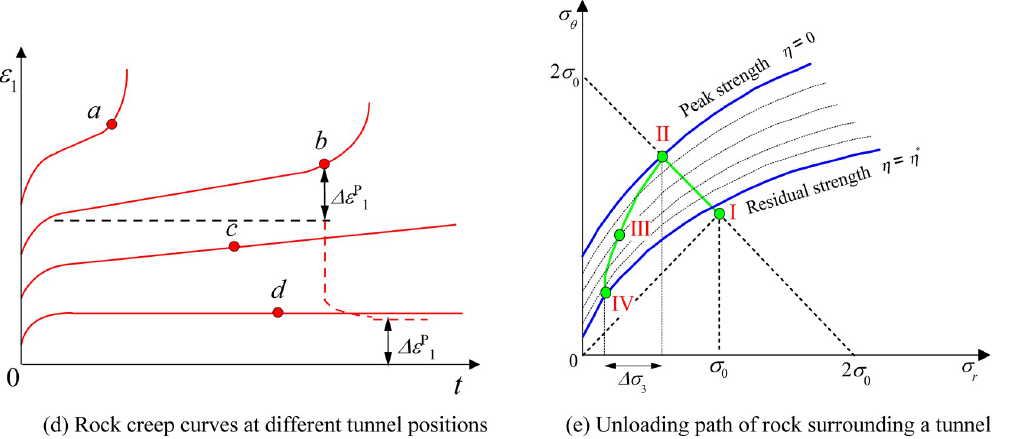
PLOS ONE | https://doi.org/10.1371/journal.pone.0256243 August 26, 2021 4 /